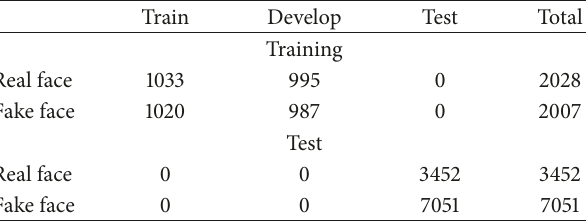
Table 1: Number of pictures on the CASIA dataset.